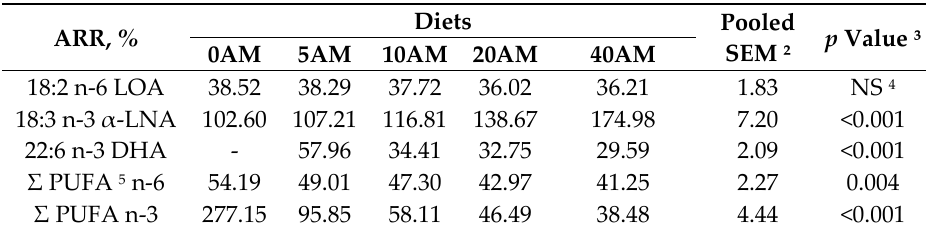
Table 4. Apparent body retention rate (ARR) of fatty acids in Nile tilapia juveniles fed increasing concentrations of Aurantiochytrium sp. meal (AM) for 87 days, at 22°C ¹. Diets ARR, %